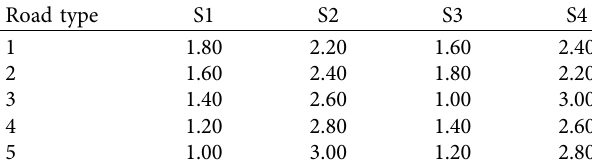
Table 7: The time-dependent speed